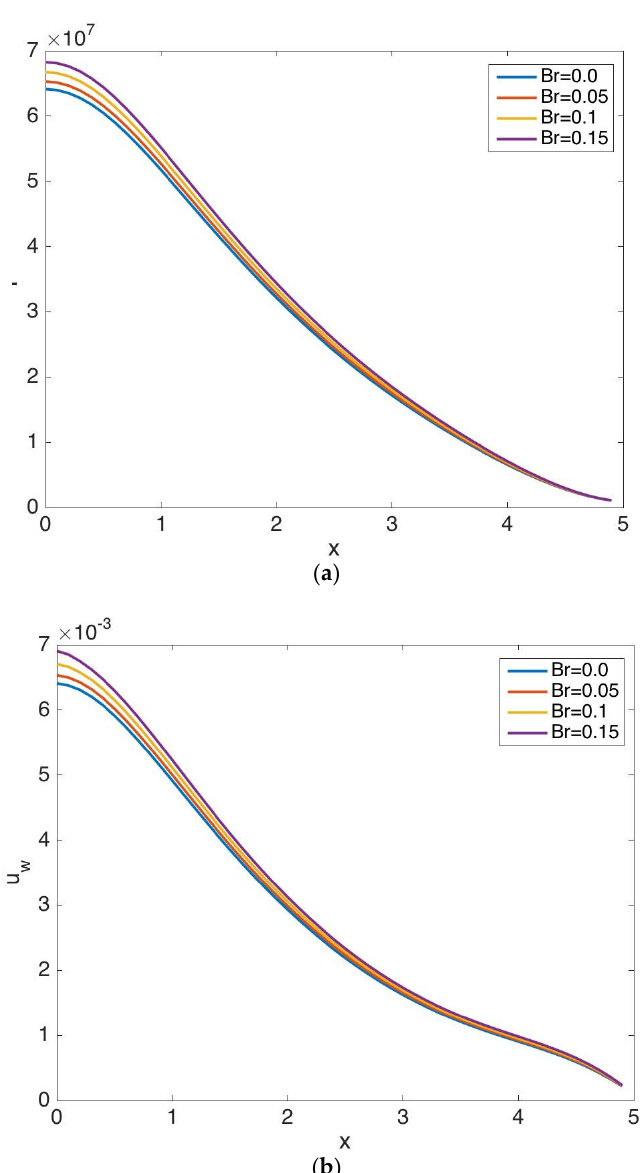
Figure 7. ( a ) Pressure and ( b ) average velocity profiles against x -axis at y = 1 m, for various values of Br of Case 1.